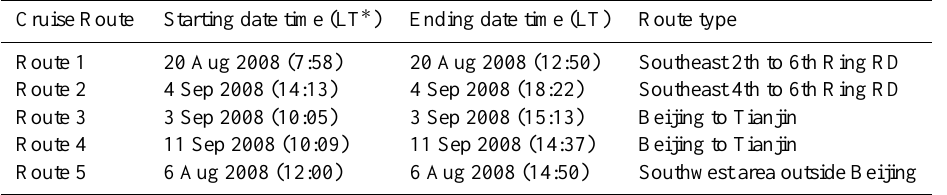
Table 1. Mobile measurement dates and route types.